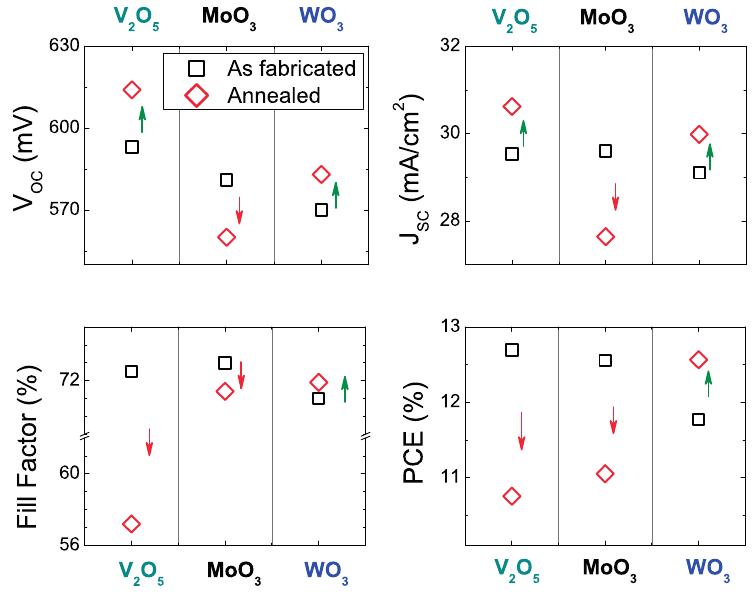
Figure 7. Solar cell performance parameters before and after thermal annealing (10 min, 160